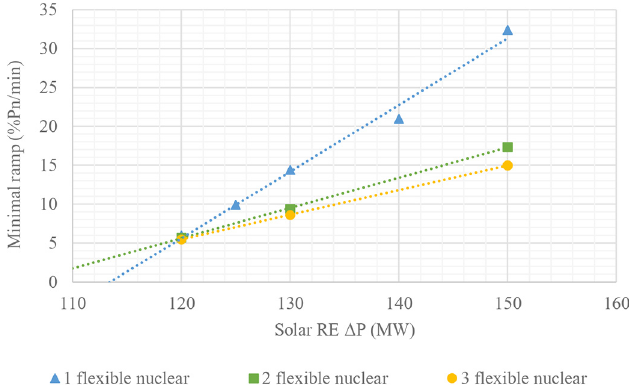
Fig. 13. Flexible nuclear ramp as function of the solar RE magnitude